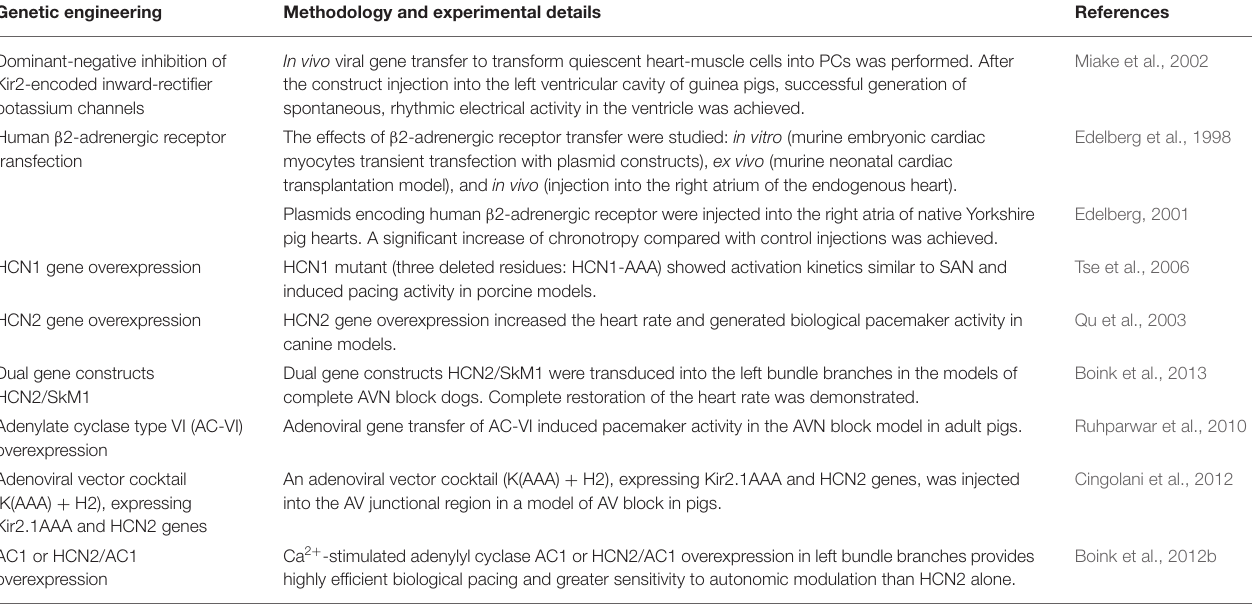
TABLE 3 | Gene-based biopacemaking